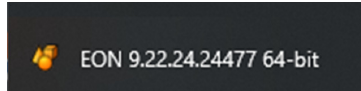
Fig. 1. EON Studio Icon.